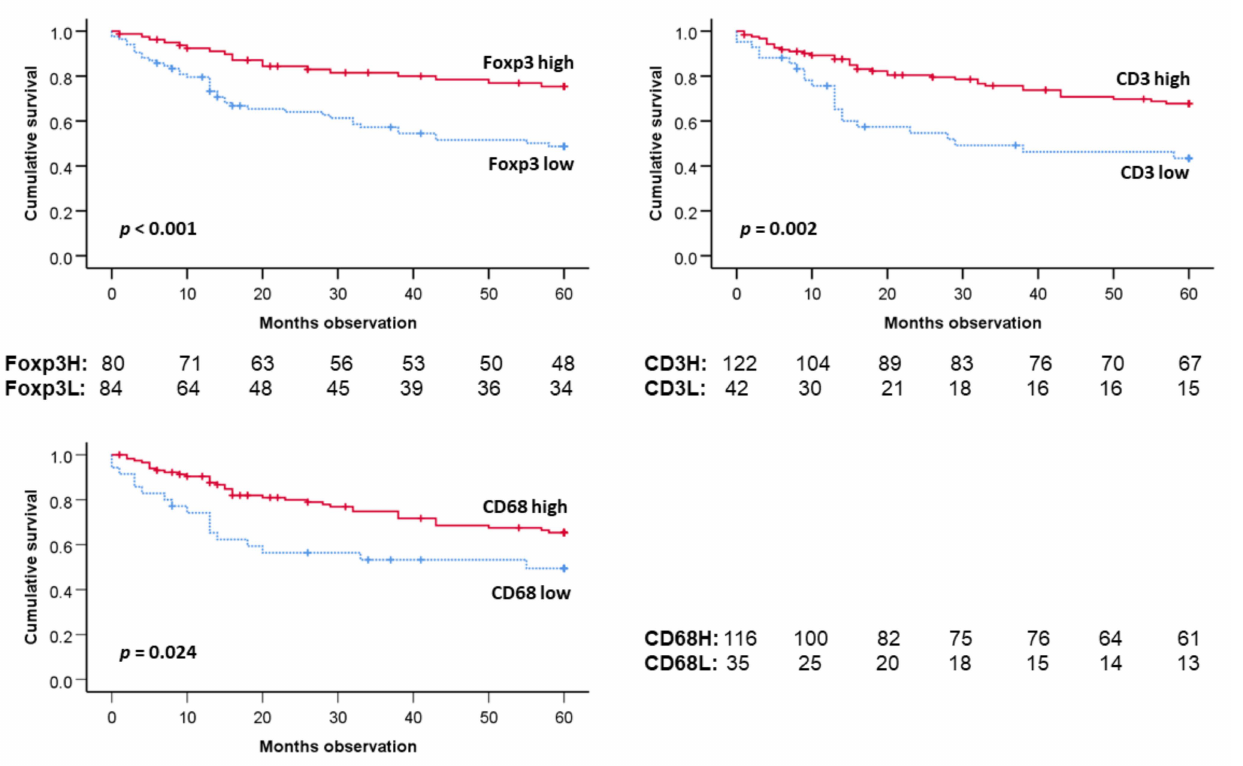
Figure 4. Five-year DSS (all patients) by TIL Foxp3 (+) ( top left ), CD3 (+) top right ), or TAM CD68+ ( bottom ) status. CD3, Foxp3 and CD68 determined by immunohistochemistry. Two bottom lines on each figure: Number of patients at risk. Survival curves and statistics by Kaplan–Meier plot with Log rank p estimation.